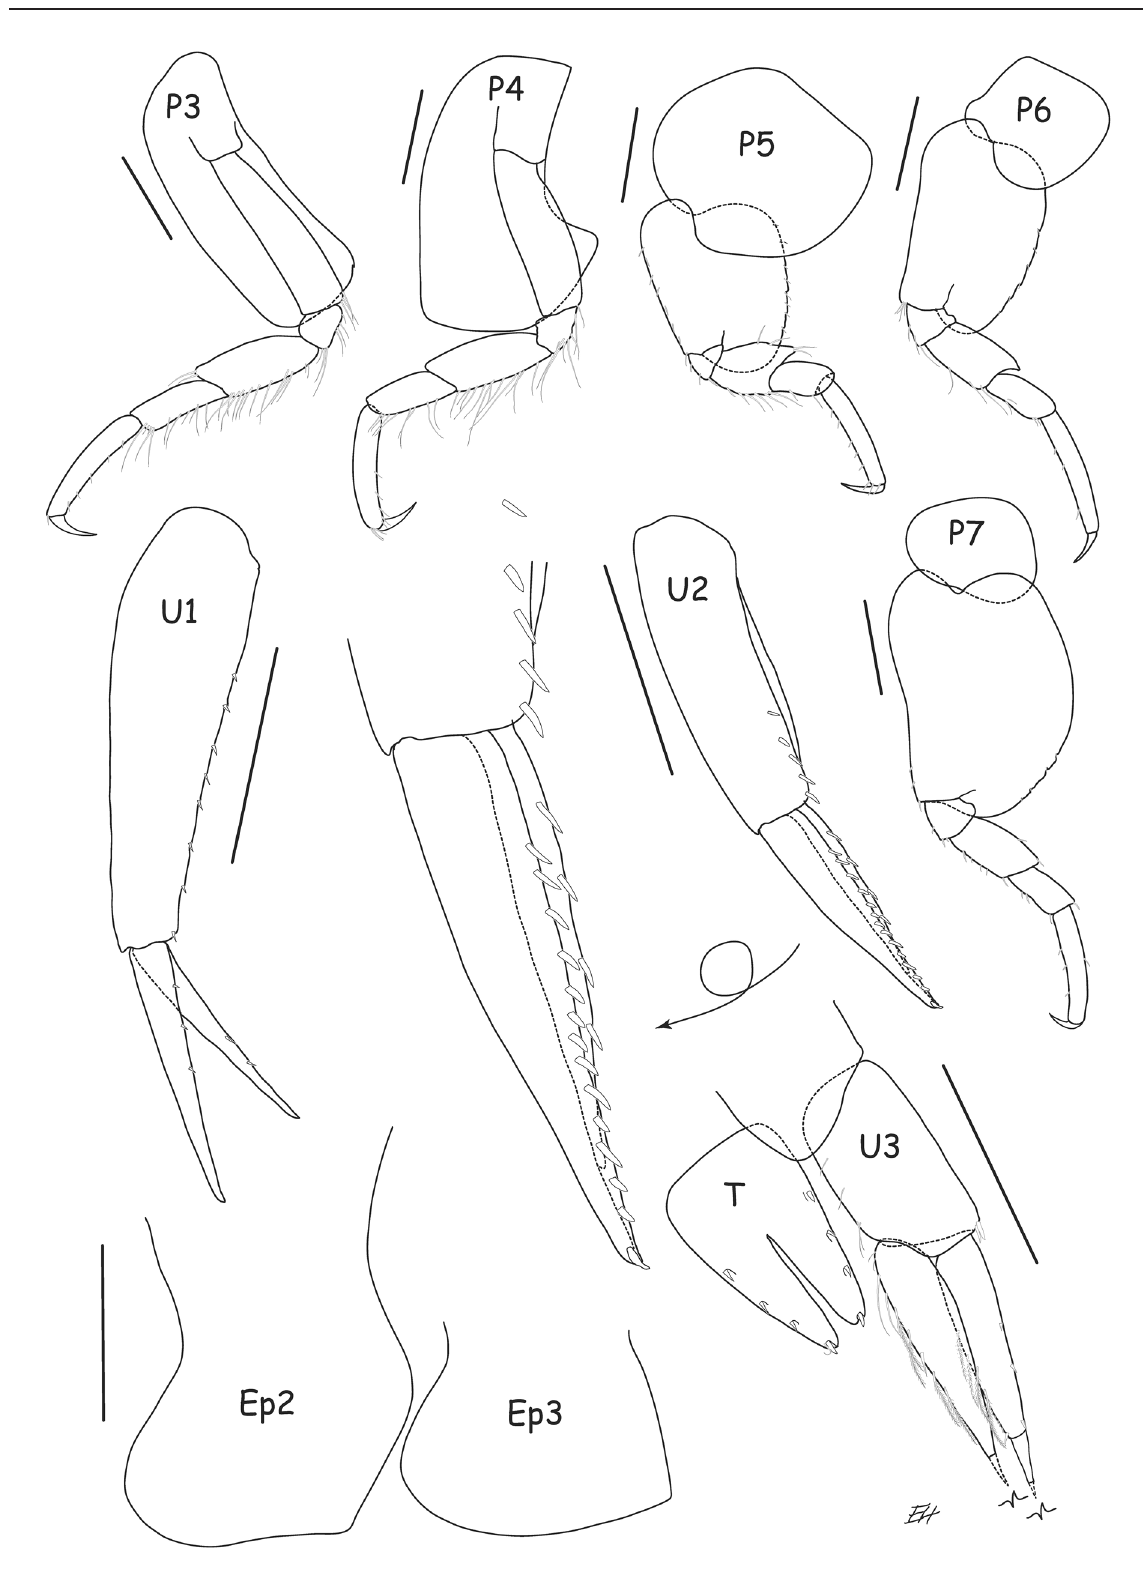
Fig. 9. Abyssorchomene abyssorum (Stebbing, 1888), holotype, ♂, 7.5 mm (BMNH 1889.5.15.23). Gills missing from P3–7. Outer ramus is oriented on the left side of the uropods. Scale bars = 0.5